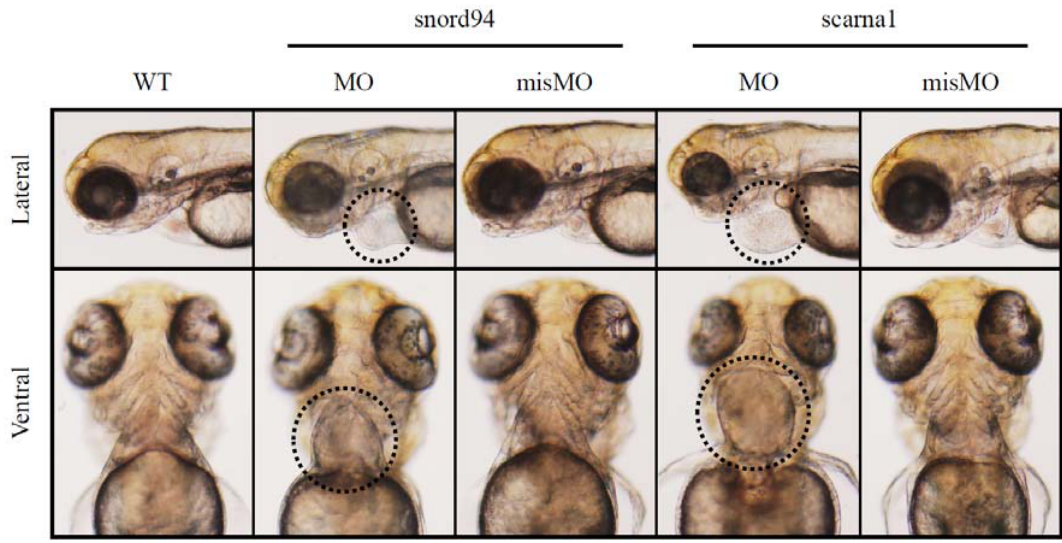
Figure 3. Representative images of zebrafish wildtype embryos (WT) and embryos treated with antisense morpholinos (MO) and mismatch morpholinos (misMO). Ventral view. The heart is circled in the morphants treated with antisense morpholinos.